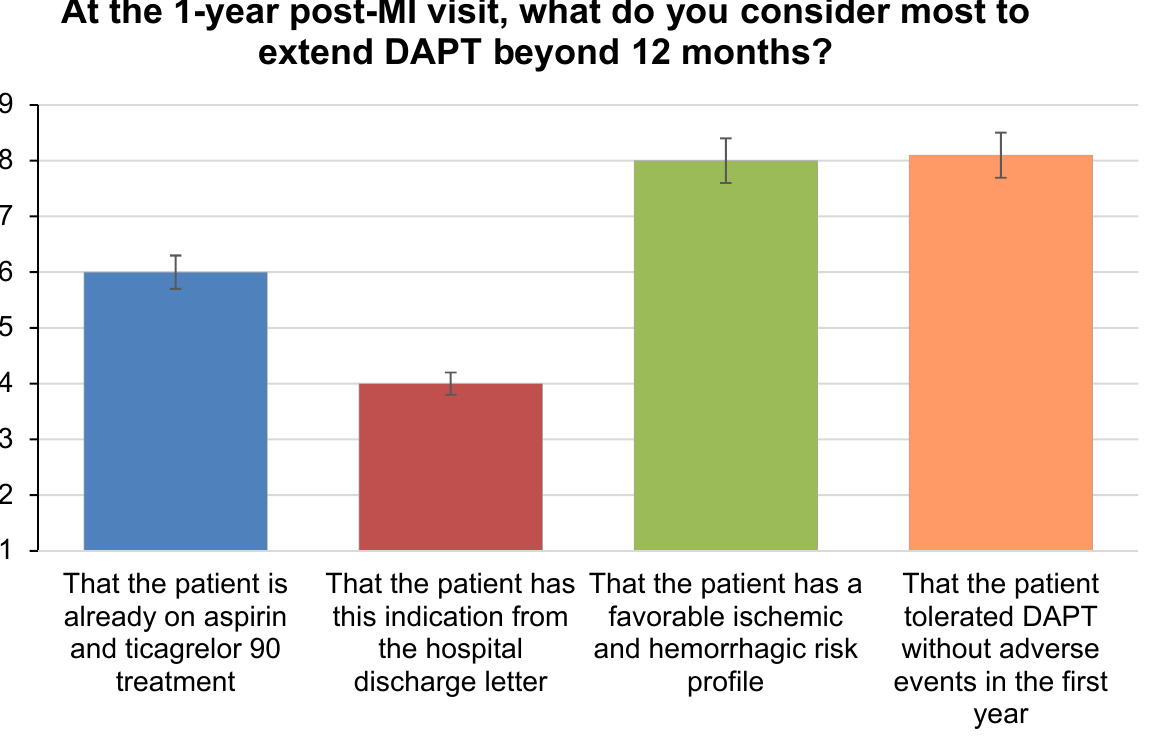
Figure 3. Most relevant elements considered in order to prolong DAPT at 12 months.